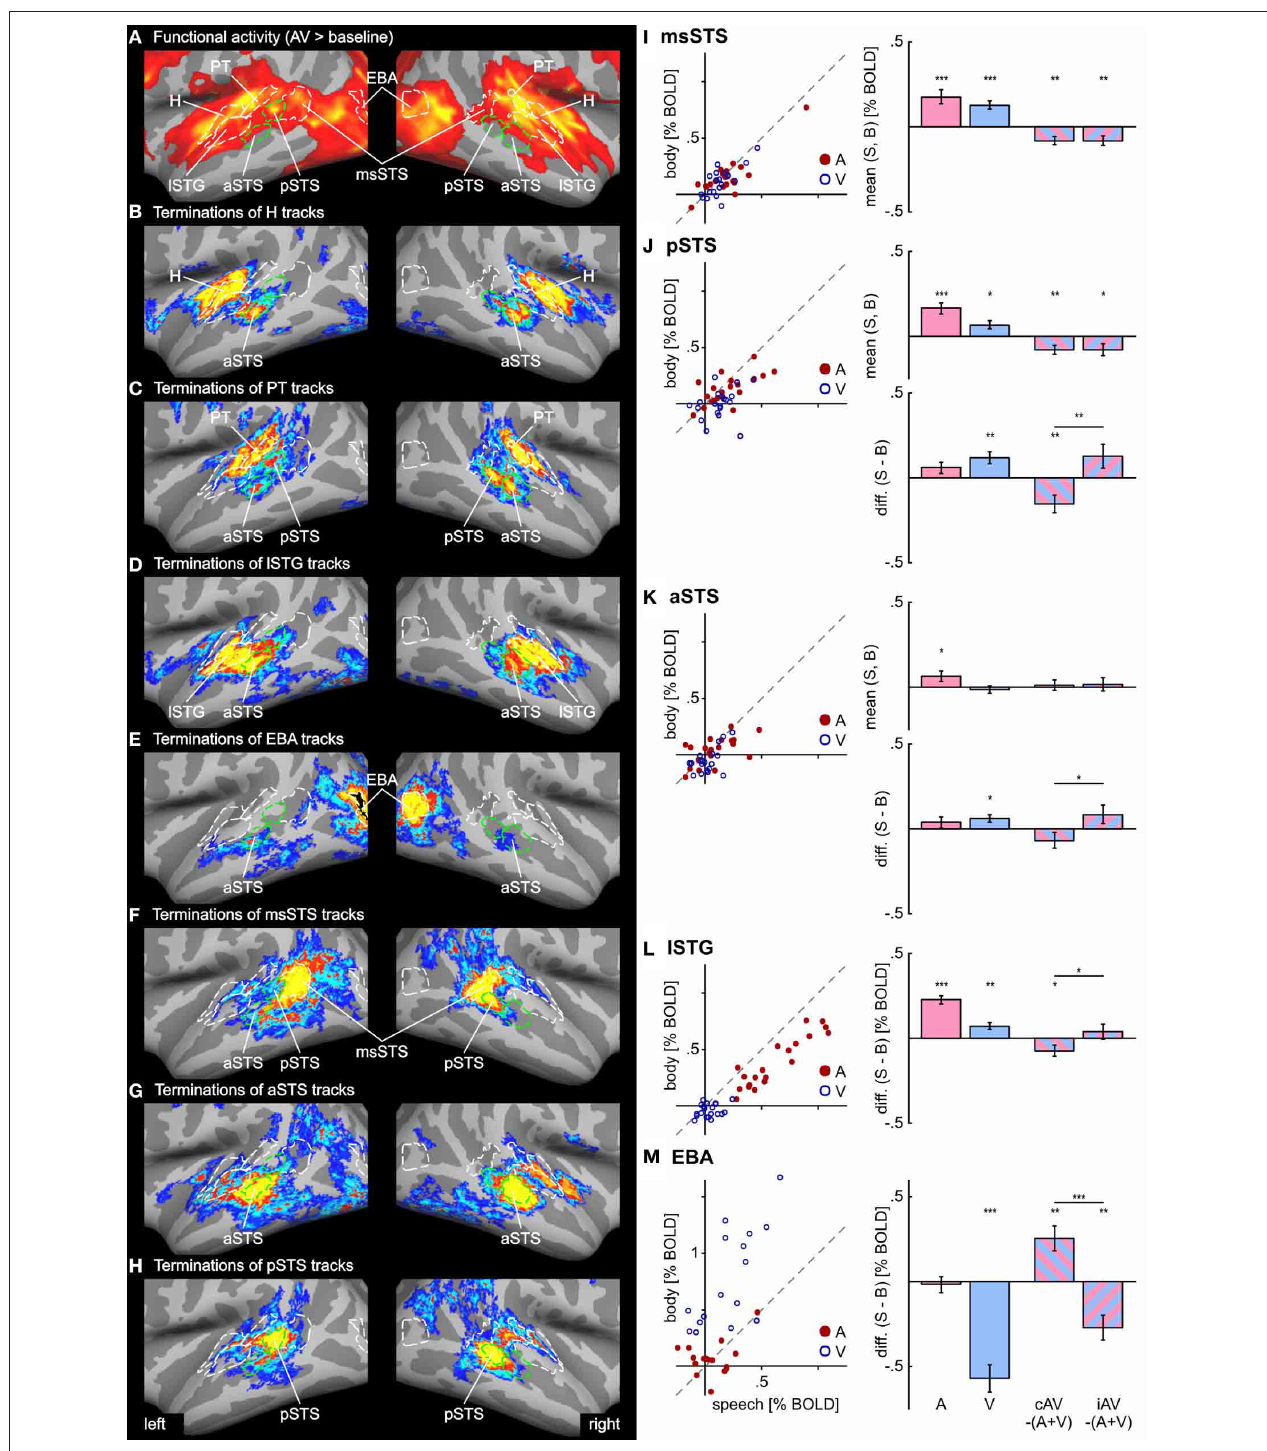
FIGURE 5 | Functional activity and track terminations in temporal cortex. Enlarged views of functional activity and track termination maps are presented in panels (A–H) . Labels (ROIs) based on track terminations are shown in green, labels (ROIs) based on functional activity in white. Panels (I–M) present the results of the functional ROI analysis for temporal cortex regions (see Tables 1 and 2 for other ROIs). BOLD responses to unimodal (auditory or visual) conditions (relative to baseline) are shown separate for all hemispheres ( n = 20) in scatter plots.